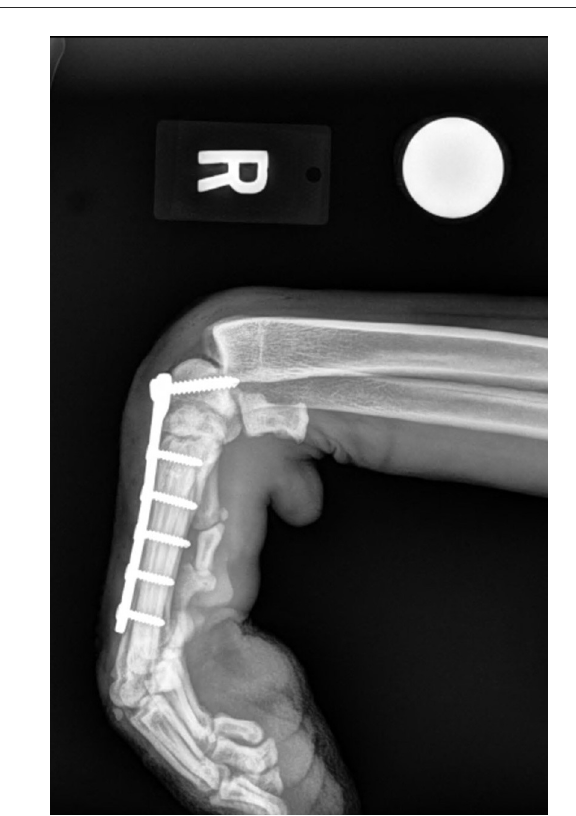
FIGURE2 Post-operative partial carpal arthrodesis lateral radiographic view of the right carpus in hyperflexion showing implant interference between the most proximal screw and the radius.